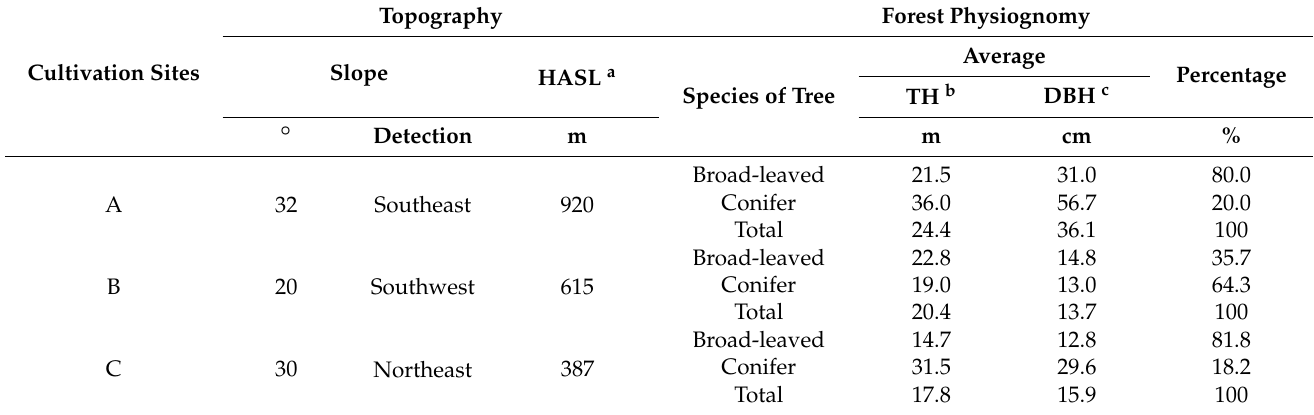
Table 1. Location environments of 13-year-old WSG cultivation